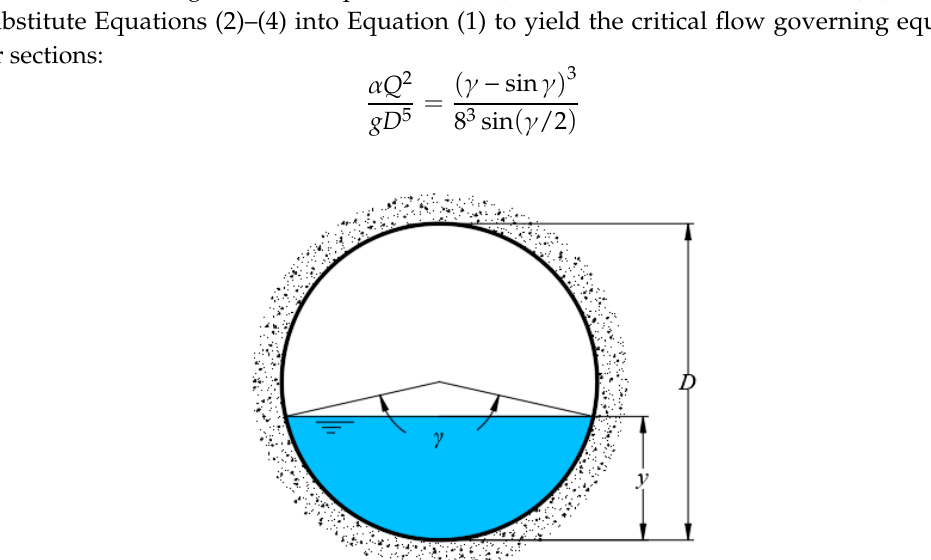
Figure 1. Cross-section of a circular conduit.